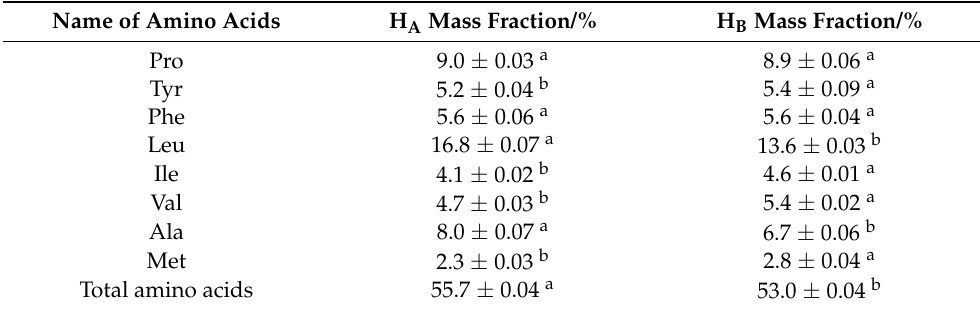
Table 1. Comparison of hydrophobic amino acid contents (%, m/m) for enzymatic hydrolysates with different bitterness.